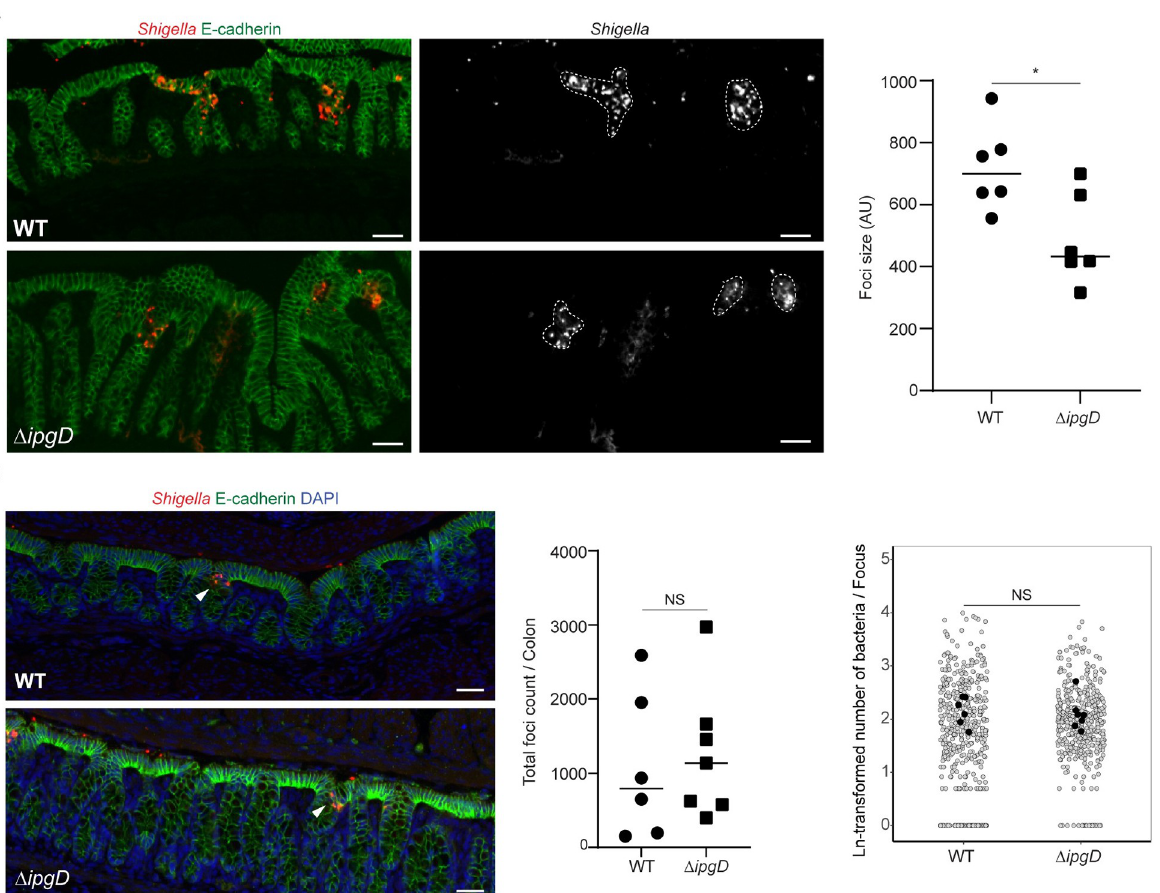
Fig 6. IpgD is required for efficient cell-to-cell spread in vivo . (A) Representative images of infant rabbit colon sections showing infection foci formed by S . flexneri (red in merged, white in Shigella panel; WT pCFP and Δ ipgD pCFP) in E-cadherin-positive epithelial cells (green) 8 hpi. Dashed lines, infection foci; scale bar, 20 μ m. Graph showing average of infection foci sizes (AU, area in arbitrary units) observed for each animal ( n = 6 per strain; WT pCFP, 130 infection foci; Δ ipgD pCFP, 88 infection foci). Statistics: unpaired t-test, � P < 0.05. (B) Representative images of infant rabbit colon sections showing invaded regions (white arrowheads) by S . flexneri pCFP (red, WT and Δ ipgD ) in E-cadherin-positive epithelial cells (green) 4 hpi; DAPI staining (blue); scale bar, 30 μ m. Graph on the left showing total number of infection foci per entire colon (WT-infected colons, 6; Δ ipgD -infected colons, 7). Statistics: unpaired t-test; NS, not significant. Graph on the right showing number of bacteria in natural logarithmic scale (Ln) at each infection focus. Black circles represent means of measurements from all frames of colon sections and gray circles represent individual measurements from each frame of colon sections. Statistics: linear mixed model analysis; NS, not significant.